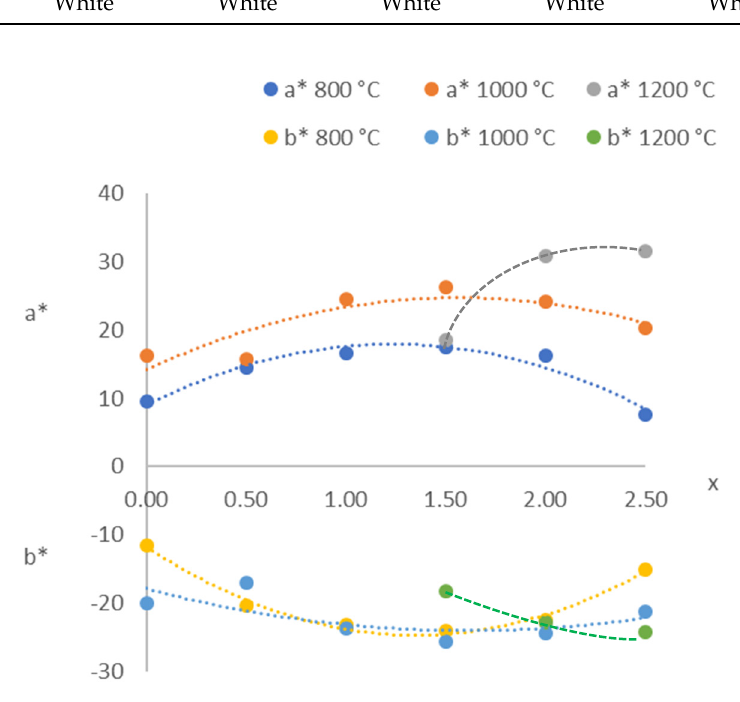
Figure 7. CIE L* a* b* from the Mg x Co 3 − x P 2 O 8 compositions fired at 800, 1000 and 1200 °C. The colour parameters of the powdered Mg x Co 3 − x P 2 O 8 (1.5 ≤ x ≤ 2.5) solid solutions in